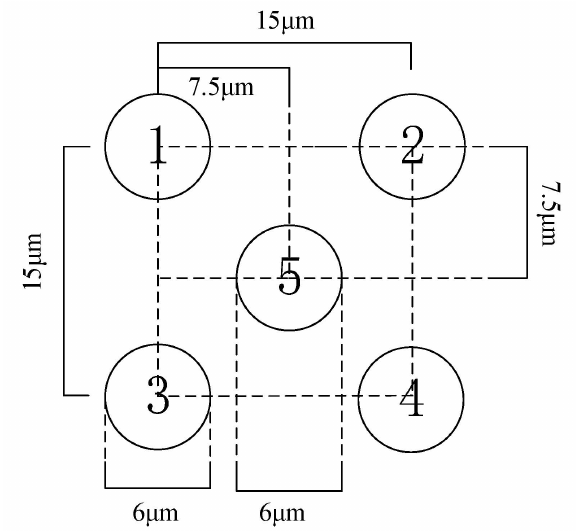
Figure 9. Distance between each cell. With the virtual cell numbered 5 in Figure 9 as the center, four controlled yeast cells are scattered in four directions numbered 1–4. The relative distance between each two controlled yeast cells is 15 µ m, and the relative distance between the virtual cell and each controlled yeast cell is 15 µ m.